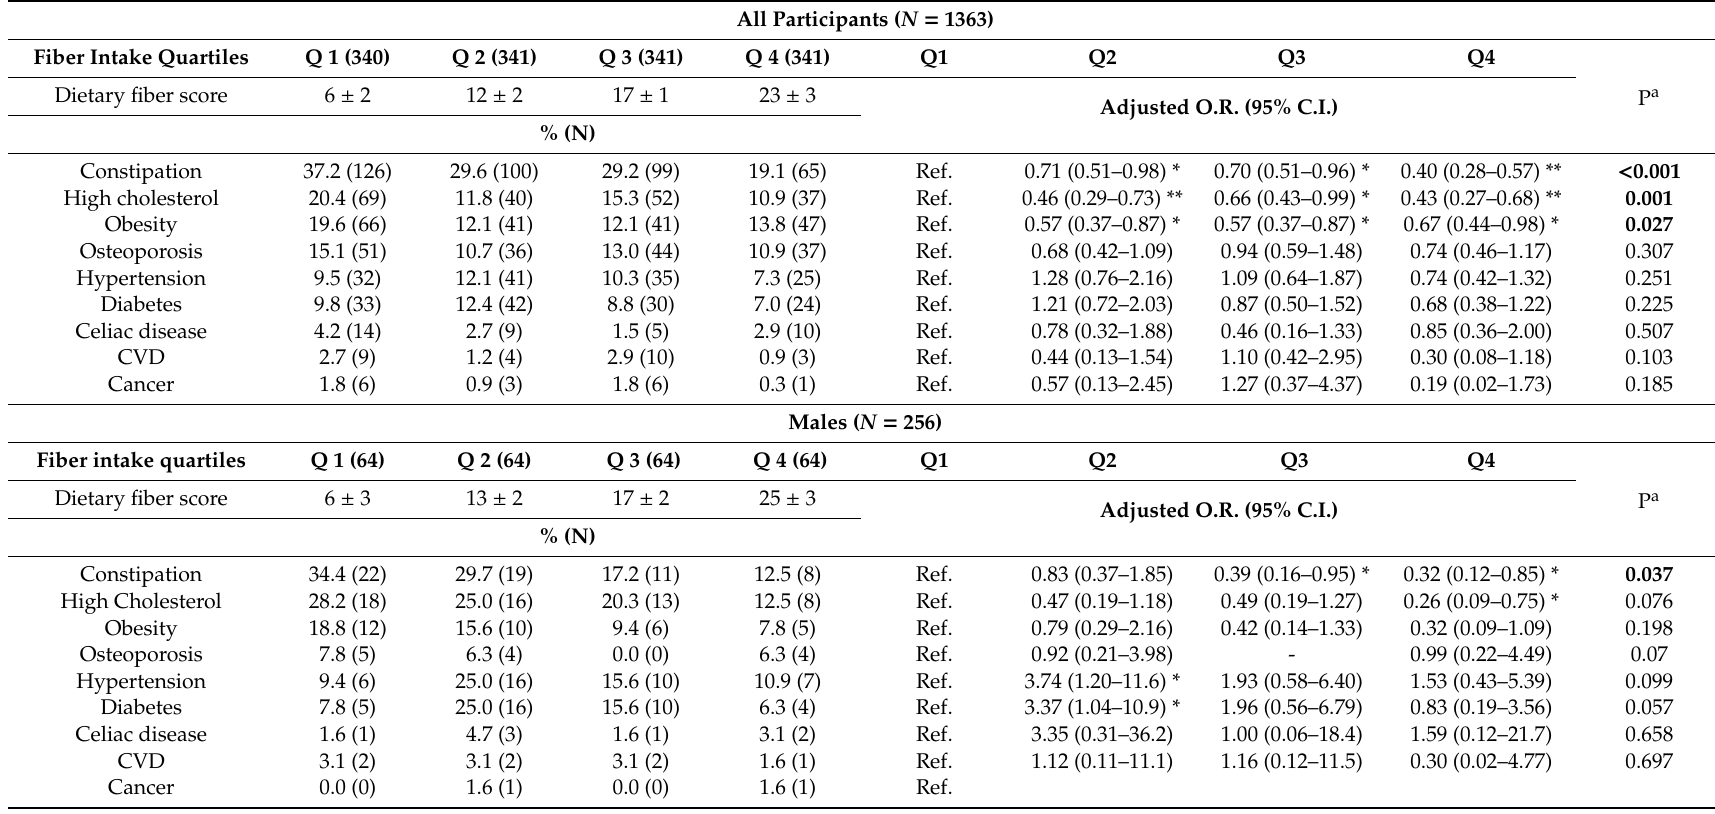
Table 5. Health status of the study participants according to the DF intake